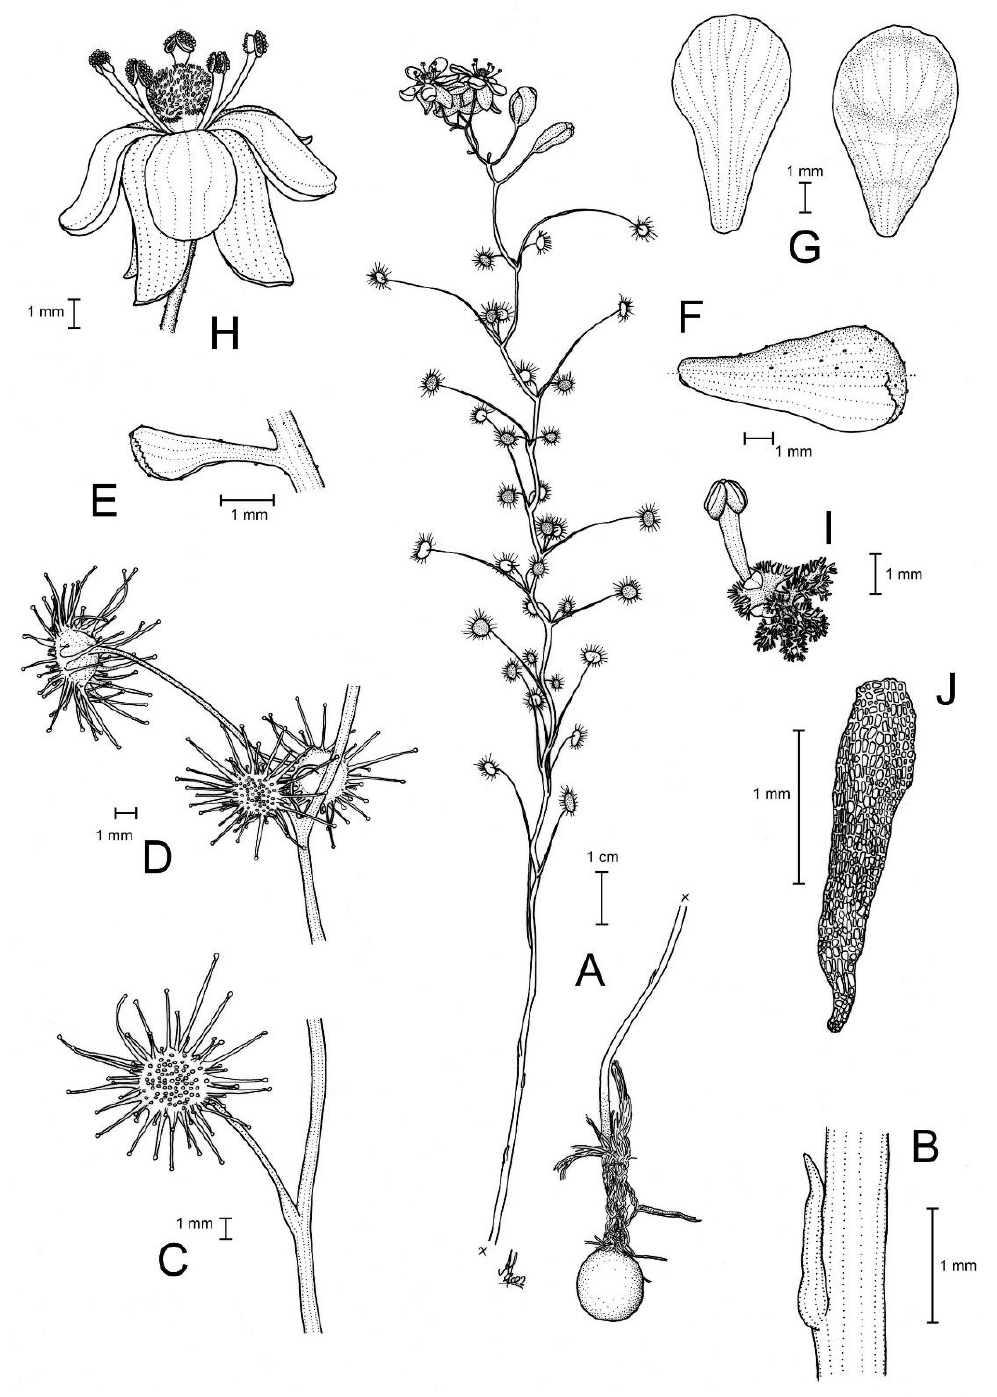
Figure 17. Drosera rubricalyx T.Krueger & A.Fleischm. ( A ) habit; ( B ) cataphyll from stem base; ( C ) cauline leaf from lower part of the stem; ( D ) group of leaves from upper node of the stem, consisting of one cauline leaf and two axillary leaves; ( E ) bract; ( F ) sepal, top abaxial view, bottom adaxial view; ( G ) petals, left pressed, right in living condition; ( H ) flower, lateral view; ( I ) gynoecium, top view, with two styles only partially drawn, one stamen from the androecium additionally depicted; and ( J ) seed. ( A , B , G -left) from the type ( J. Drummond coll. VI n. 110 ), ( C – G -right, H – J ) from photographs taken near Jurien Bay, Western Australia. Drawing: A. Fleischmann.